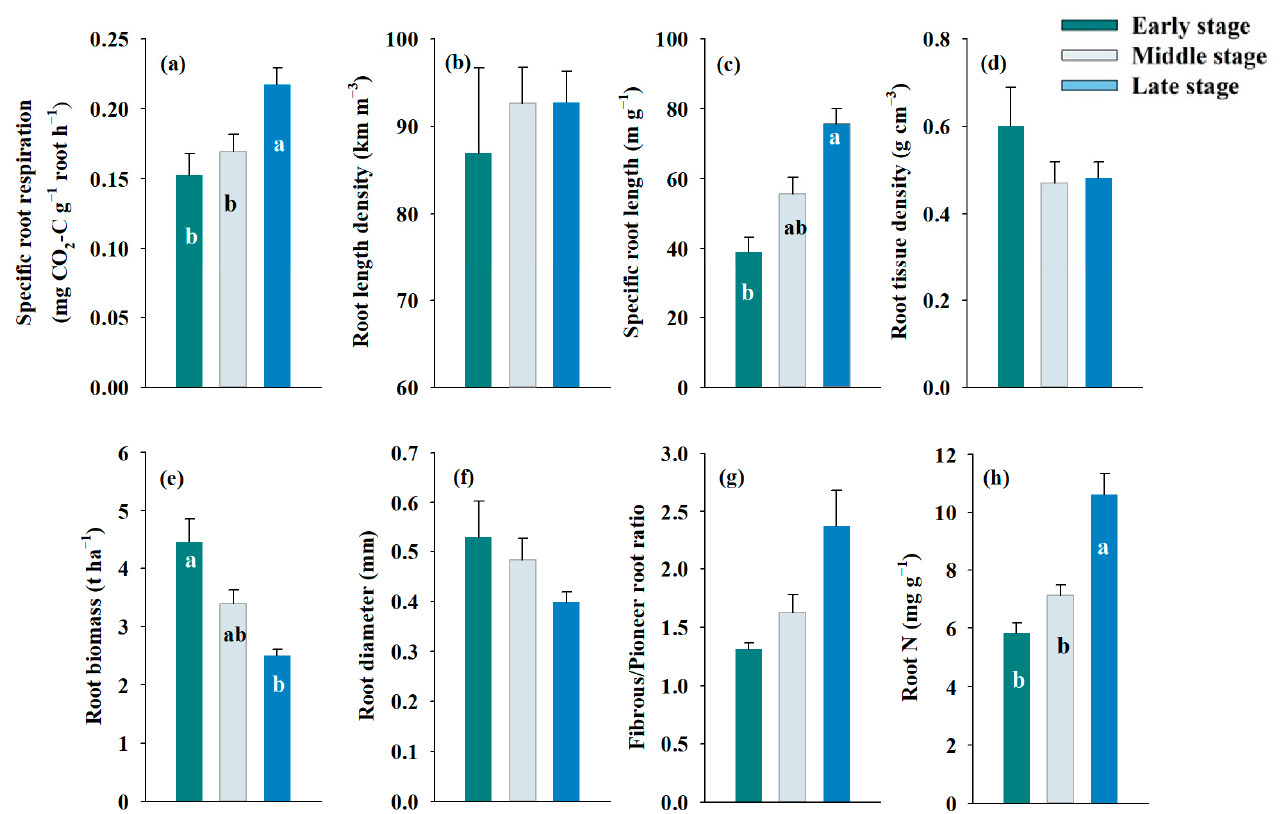
Figure 4. Fine-root traits in the top 20 cm of soils at three successional stages. Including specific root respiration ( a ), root length density ( b ), specific root length ( c ), root tissue density ( d ), root biomass ( e ), root diameter ( f ), fibrous/pioneer root ratio ( g ), and root N ( h ). Different lowercase letters indicate significant differences among successional stages, p < 0.05. Bar charts represent mean values, vertical bars represent the standard error.